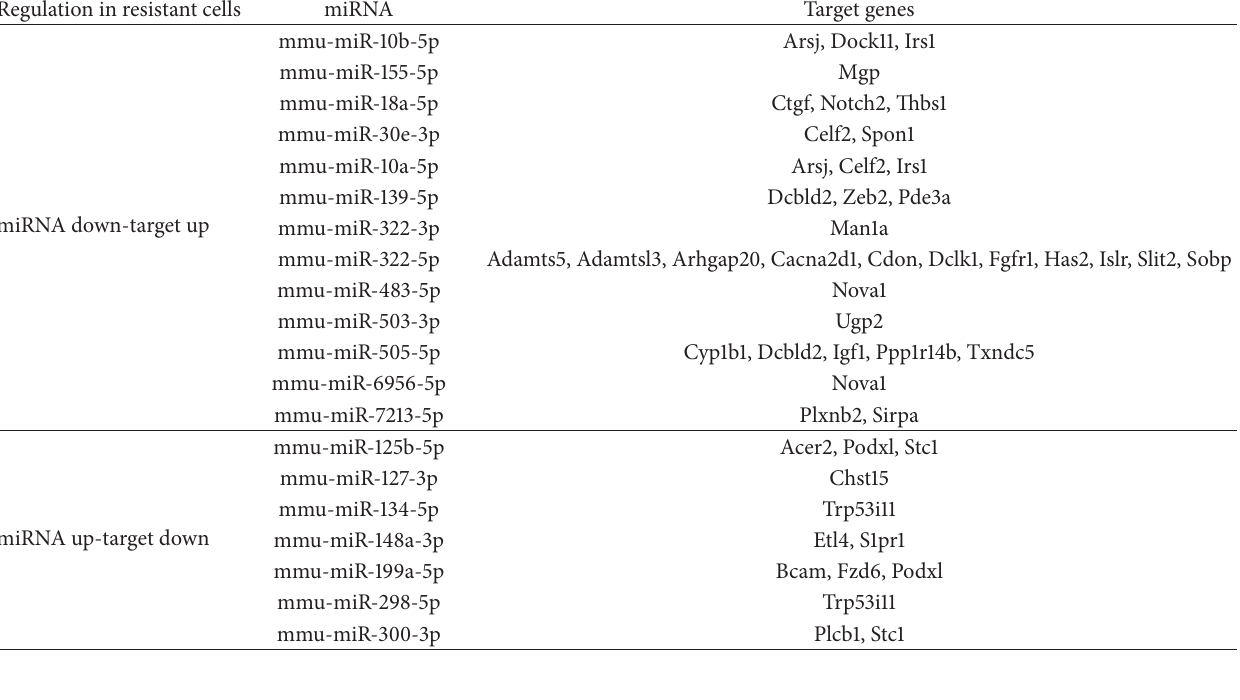
Table 3: The miRNA-mRNA regulation pairs.